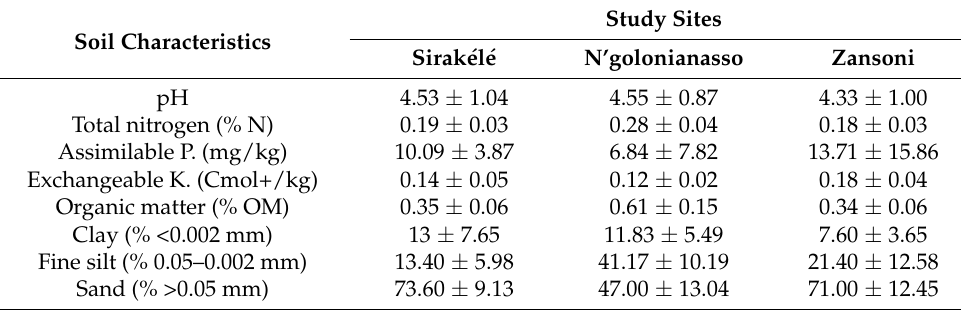
Table 1. Soil physico-chemical properties of the study